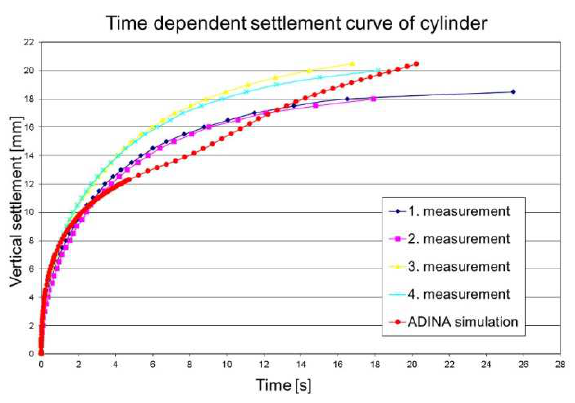
Figure 5. Creep curves (time vs. settlement) of the imprint